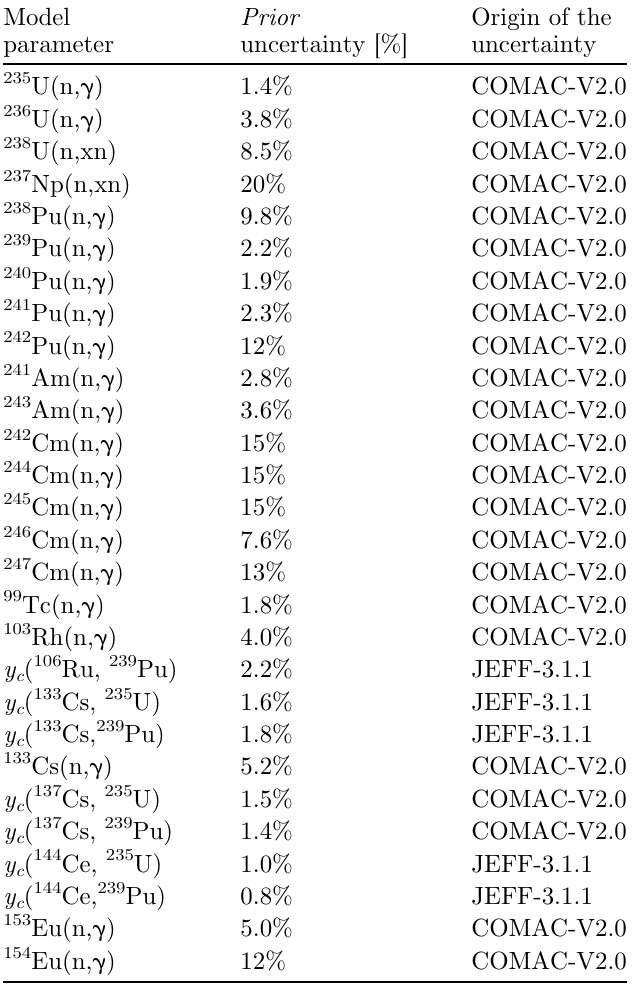
Table 2. Fitted parameters, relative prior uncertainty and origin of the uncertainty.